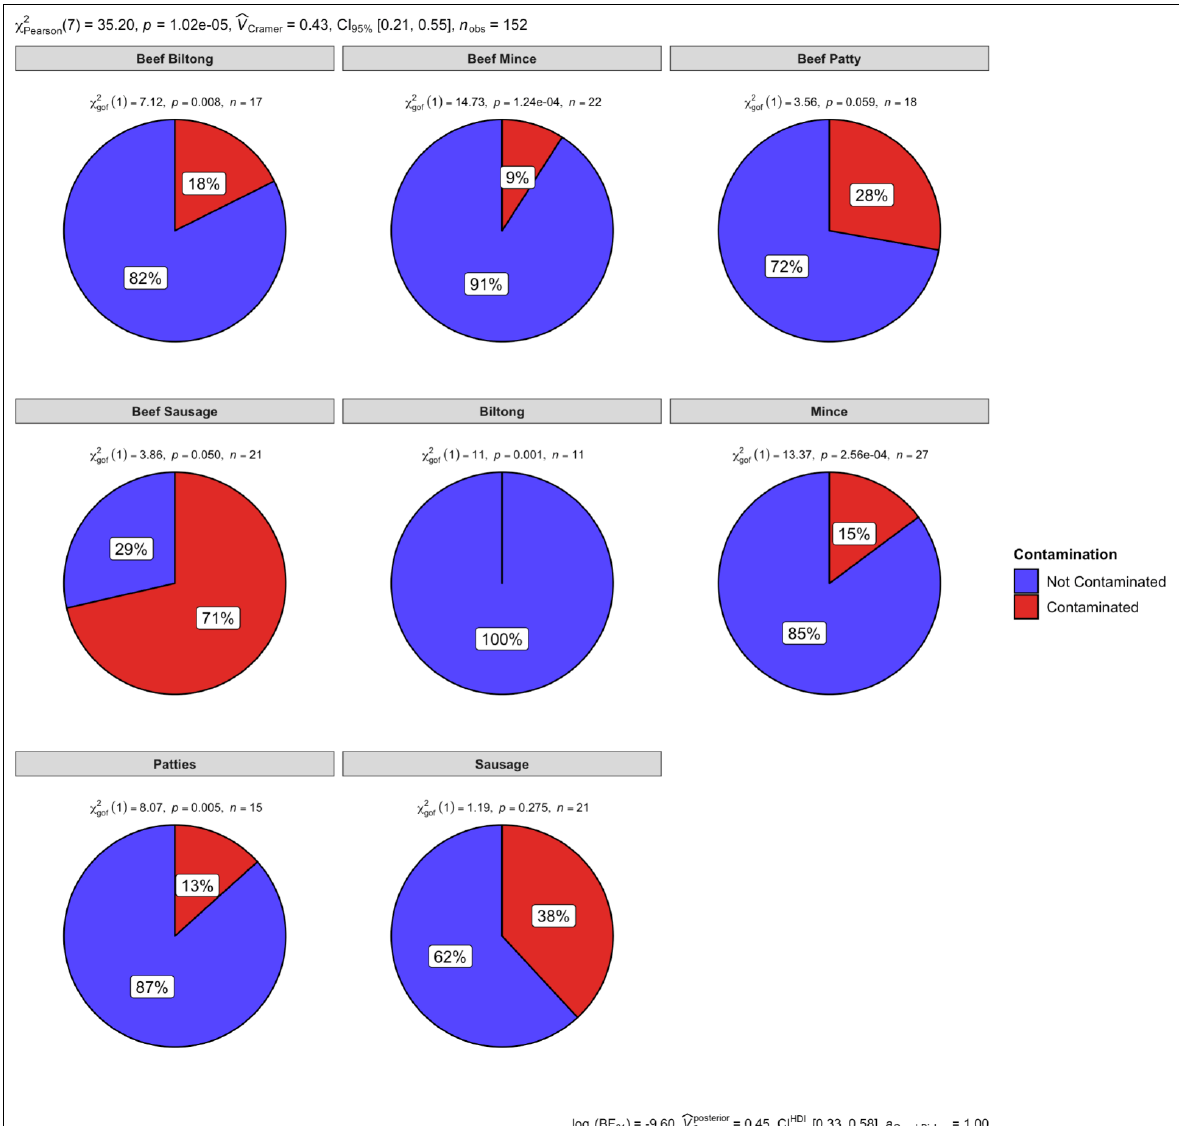
Figure 13. Proportional test for biltong, mince, patty, and sausage